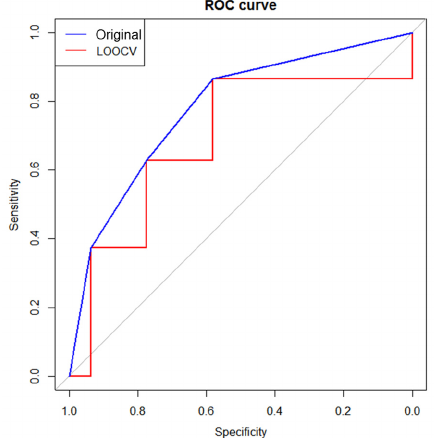
Figure 4. ROC curve of a two ‐ metabolite set (glycine + N ‐ phenylacetylglycine) by LOOCV. The blue and red ROC curves were generated using the original data set and the LOOCV data set. The gray diagonal line represents the reference line of 0.5. LOOCV, leave ‐ one ‐ out cross ‐ validation.